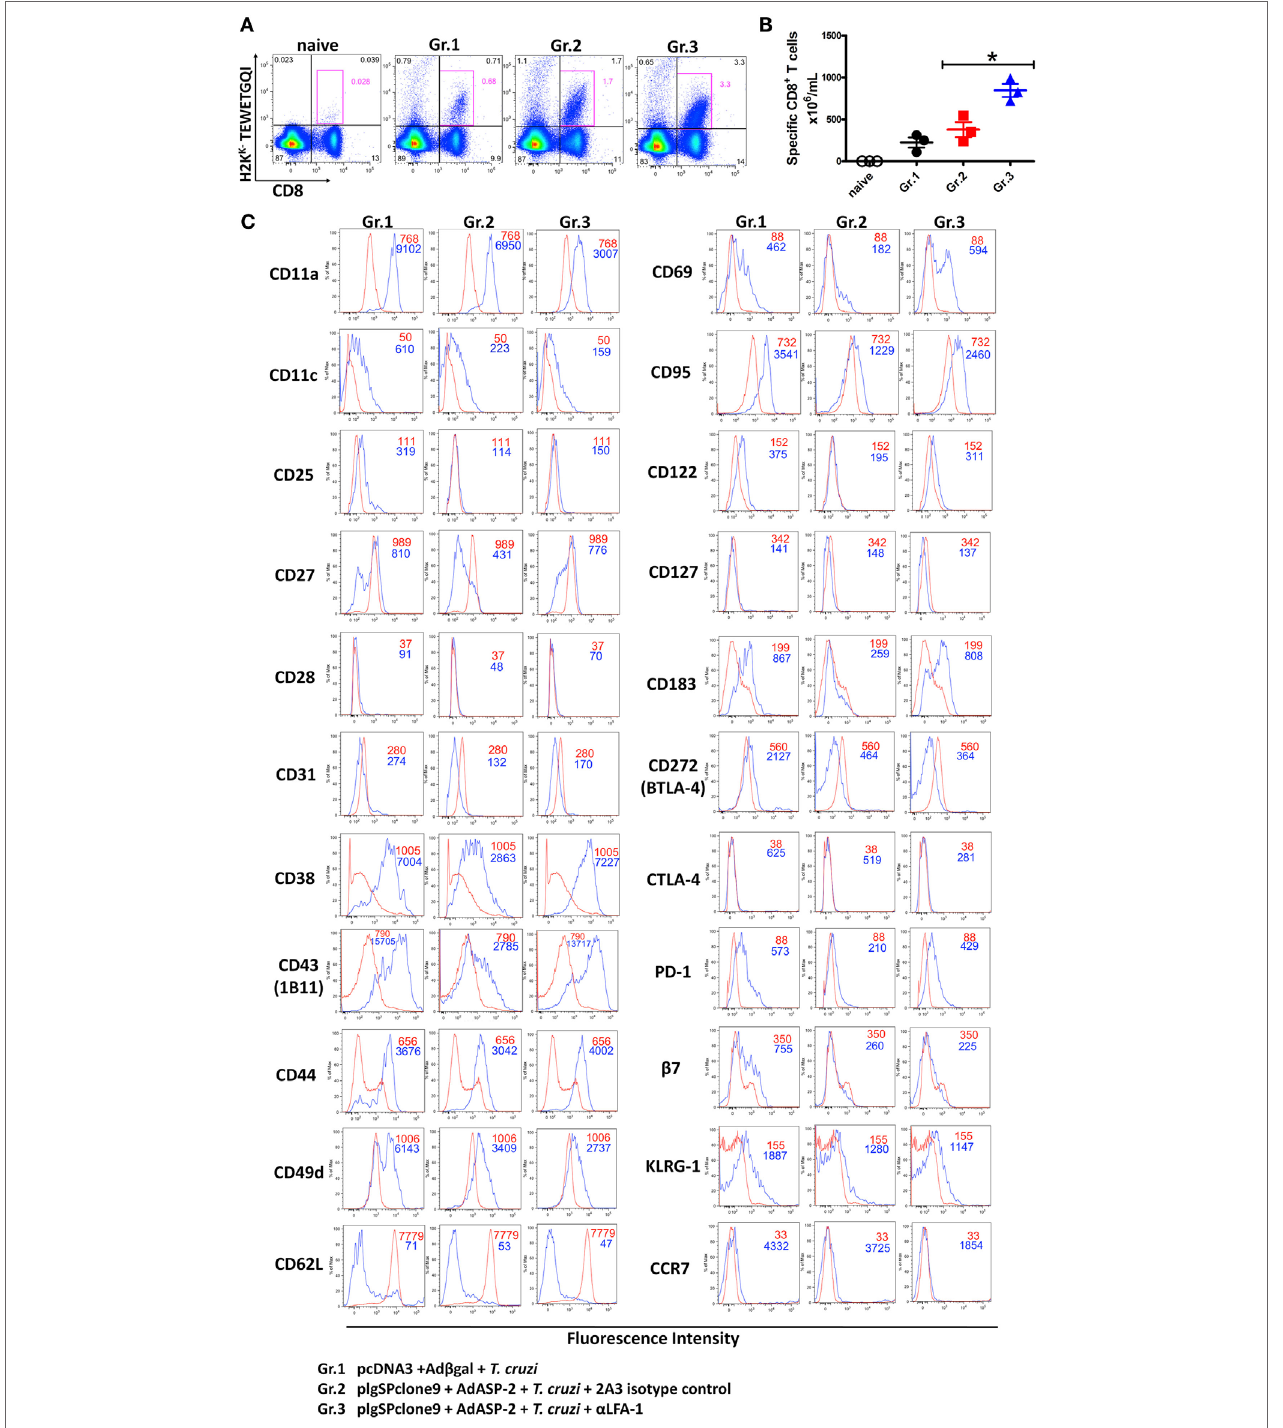
FigUre 3 | Effector CD8 + T lymphocytes express high levels of CD95 on the surface after anti-LFA-1 treatment. A/Sn mice were immunized with ASP-2 using the heterologous “prime-boost” vaccination regimen, infected with 150 trypomastigotes forms of Trypanosoma cruzi and treated with anti-LFA-1 or isotype control until the 20th after infection. In this day, the splenic cells were labeled with H2K K -TEWETGQI multimer, anti-CD8 and surface markers. (a) The frequency of specific CD8 + T cells in the spleen. (B) Absolute number of specific CD8 + T cells in the spleen. (c) Histograms with MFI of each marker analyzed in different groups. The red line represents the naive group, whereas the blue line represents groups 1, 2, and 3. Results in panels (a,B) are individual values with the mean ± SD of groups ( n = 4), while in panel (c) representative analyses are shown for four mice per experiment. The experiment was performed two or more times with similar results. Statistical analysis was performed using the one-way ANOVA. Asterisks denote statistically significant differences between the groups 2 and 3 ( P <